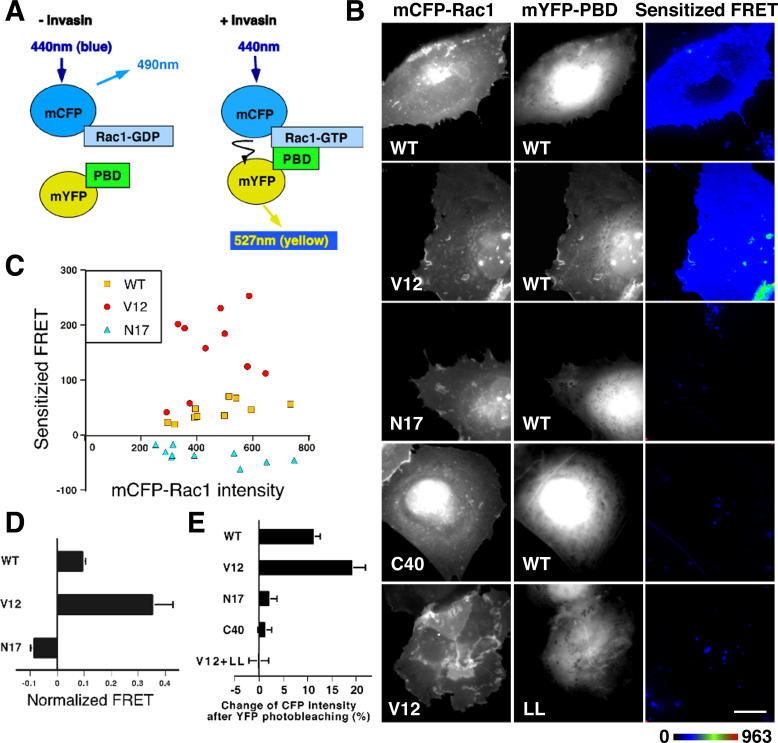
Activation of Rac1 in Single Cells as Demonstrated by FRET(A) Schematic representation of intermolecular FRET from Rac1-GTP to PBD. In the absence of GTP loading, mCFP-Rac1 is unable to bind mYFP-PBD. Upon GTP loading (activation) of Rac1, mCFP-Rac1-GTP is able to bind to the downstream effector construction mYFP-PBD. This allows the emission from mCFP to excite mYFP, resulting in emission at 527 nm.(B) Display of fluorescence emission and sensitized FRET in individual transfectants. COS1 cells cotransfected with various mCFP-Rac1 derivatives and either mYFP-PBD or mYFP-PBD(LL) were subjected to FRET analysis, and sensitized FRET was calculated (Materials and Methods). Displayed are the channels for CFP and YFP emission as well as the relative Rac1 activation throughout the cell as determined by sensitized FRET. The color-scale bar represents the amount of Rac1 activation displayed as relative pixel intensity in noted area of cell (Materials and Methods). White bar represents 10 μm.(C) FRET is dependent on coexpression of active mCFP-Rac1 and mYFP-PBD. FRET from ten ROIs, which represented two cytoplasmic regions from each of five cells, were plotted as a function of the intensity of the mCFP-Rac1 donor.(D) Activation of Rac1 increases normalized levels of FRET. Data from (C) were normalized to amount of mCFP-Rac1 in each region of interest and displayed. Displayed are means ± standard errors of the mean (SEMs)(E) Enhanced emission of the mCFP-Rac1 donor resulting from acceptor photobleaching requires Rac1 activation. The acceptor mYFP-PBD was selectively photobleached for 2 min, and amount of mCFP-Rac1 donor emission was compared before and after irradiation (Materials and Methods). The percentage increase in emission of after irradiation is displayed. To determine emission enhancement, ten ROIs were analyzed. Displayed are means ± SEMs.